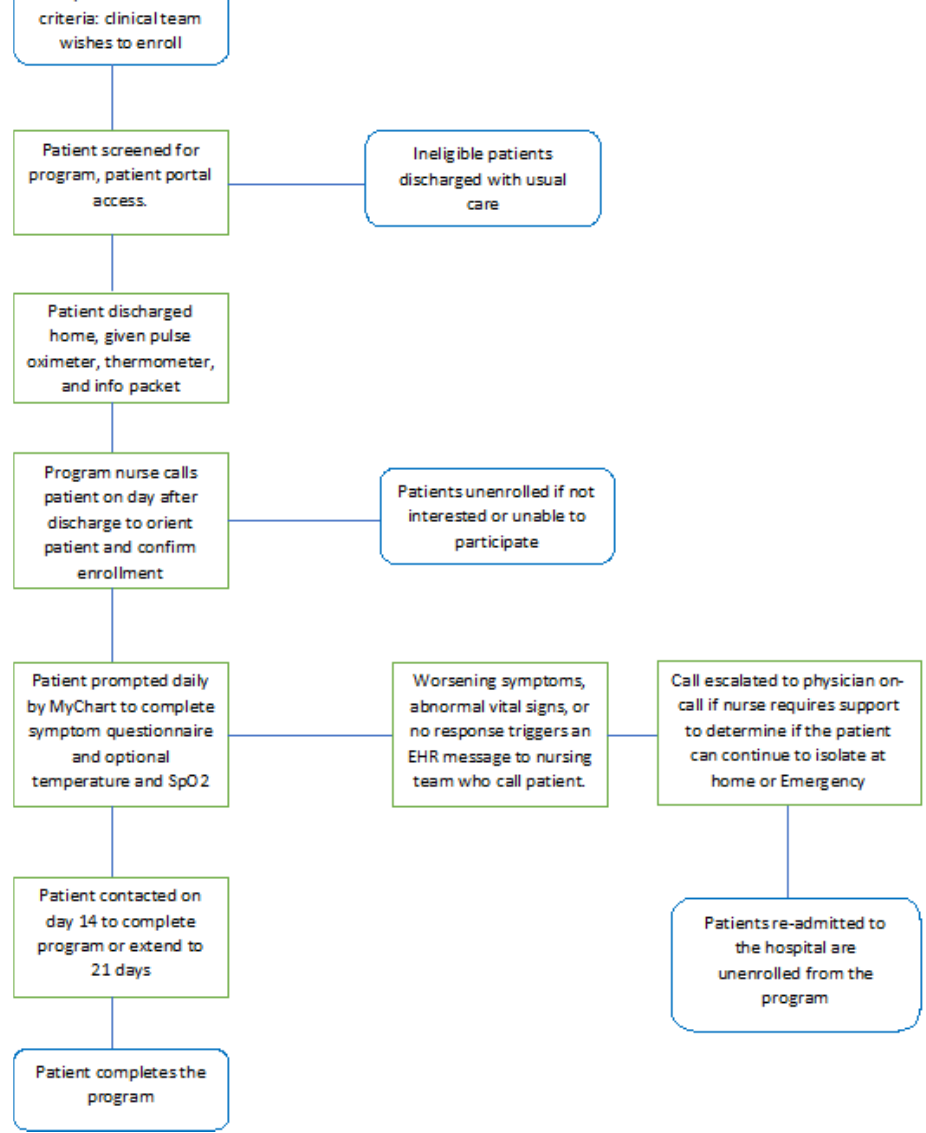
Figure 2. Detailed enrollment workflow for patients with COVID-19 being discharged from one of the five participating hospitals with the Remote Patient Monitoring program [54].